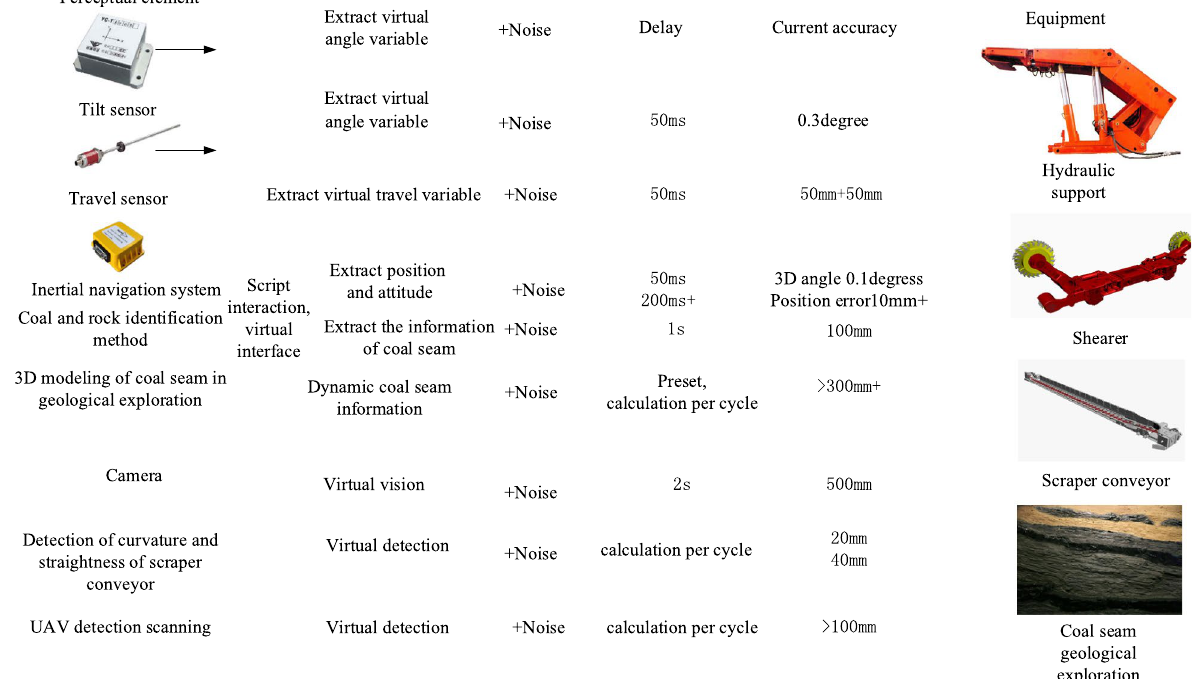
Fig. 5 Composition of the virtual perception